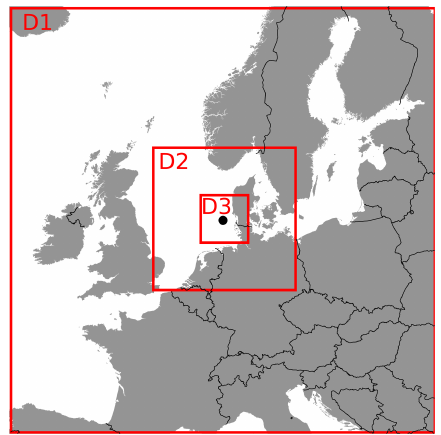
Figure 4. Mesoscale model domain distribution around the FINO3 site. The red boxes mark the extension of the computing domains. The coastline and border data originate from the GSHHS dataset (Wessel and Smith,